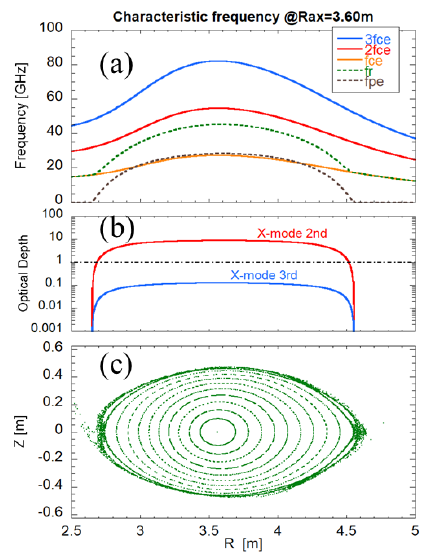
Fig. 1. (a) Radial profile of characteristic frequencies in the major radial direction in the LHD horizontal crosssection at B t =1T and R ax =3.60m. The blue line is the 3rd harmonic 3 f ce , the red line is the 2nd harmonic 2 f ce , the yellow line is the fundamental f ce , the green dotted line is the right-hand X-mode cutoff frequency, and the brown dotted line is the electron plasma frequency f pe . Here the electron density is calculated as n e0 =1x10 19 m -3 at the center. (b) Optical thickness at T e = 2 keV, where the X- mode 2nd harmonic f ce exceeds 1 almost everywhere in the plasma confinement region. (c) Closed flux surface per  = 0.1 and ergodhic region in